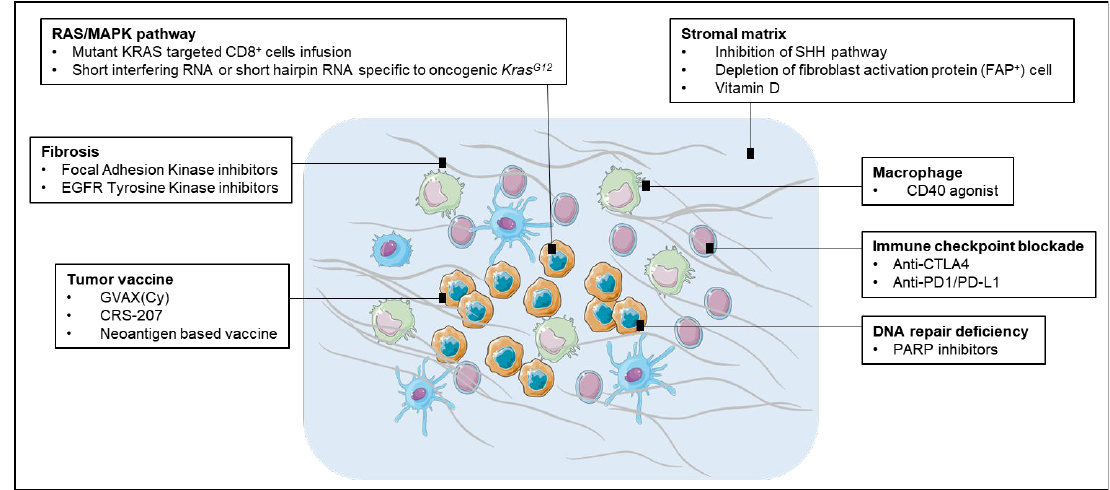
Figure 2. Potential immunotherapeutic targets for pancreatic cancer